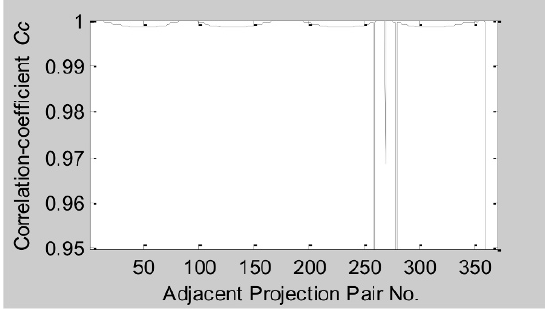
Figure 10. Correlation-coefficient for Rotational motion case.